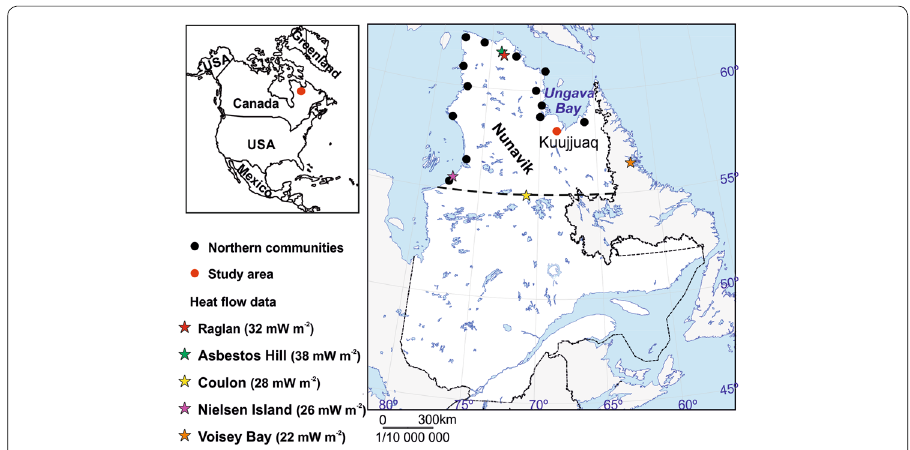
Fig. 1 Geographical location of the community of Kuujjuaq and remaining communities of Nunavik (Canada) and of the heat flow assessments: Nielsen Island (Jessop 1968), Voisey Bay (Mareschal et al. 2000), Camp Coulon (Lévy et al. 2010), Raglan and Asbestos Hill mining sites (e.g., Comeau et al.